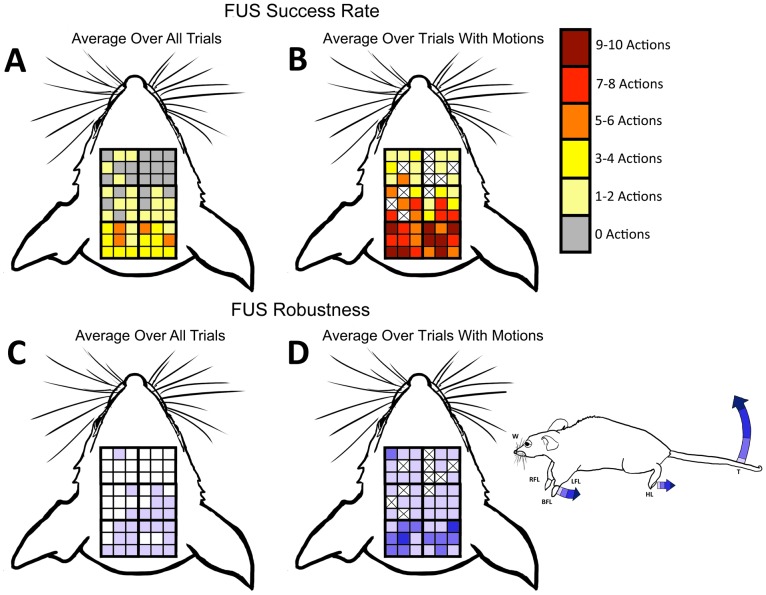
Metrics for successful stimulation by FUS.Measures of robustness and success rate of induced motions by FU averaged over 5 mice. The X’s in (B) and (D) indicate that no movement in those regions was ever observed. X’s are not shown in (A) or (C) because there is the possibility that the data rounded down to 0 (<0.5 actions).